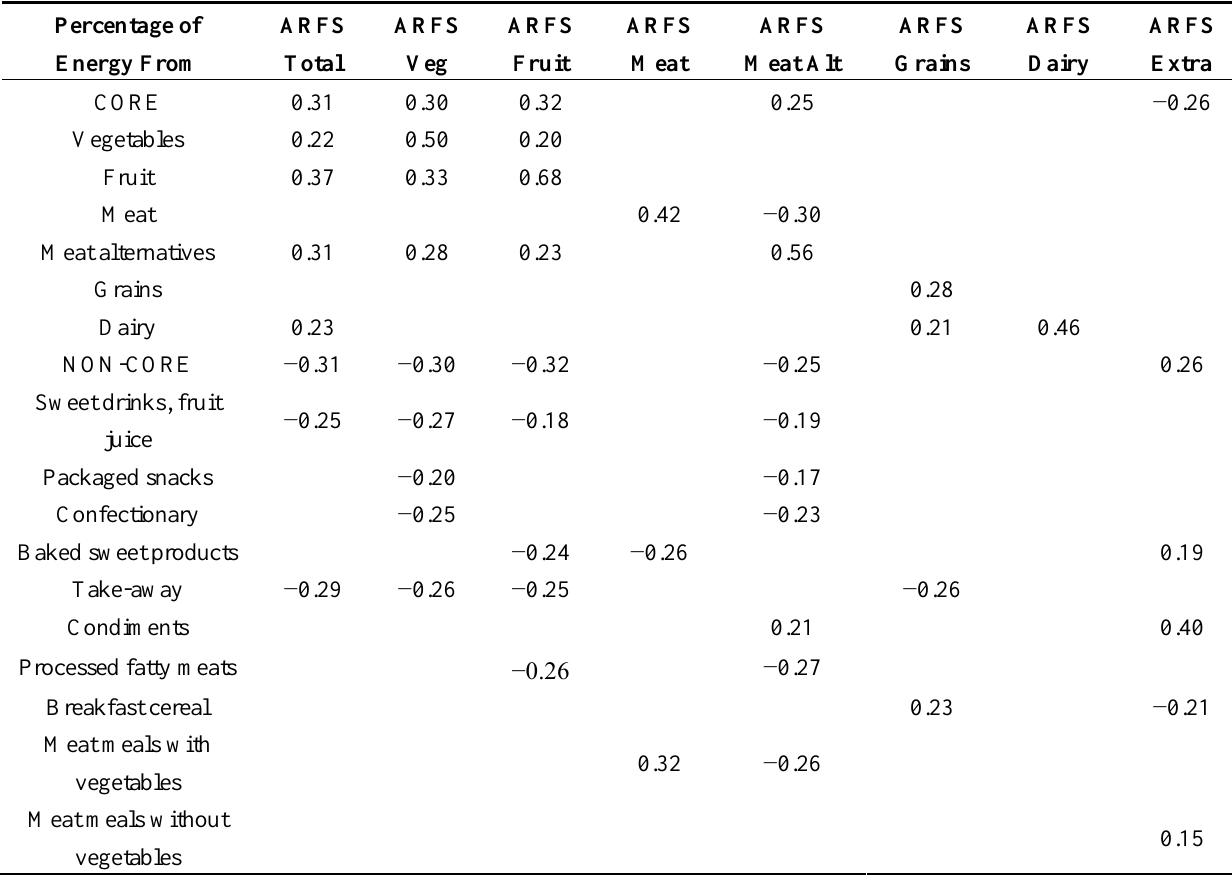
Table 6. Correlations between the Australian Recommended Food Score (ARFS) and the Australian Eating Survey (AES) FFQ food groups, adjusted for total FFQ energy, significant at the 5% level. Light grey shaded cells are those with the same group in row and column where positive correlation would be anticipated. Dark grey shaded cells are negative